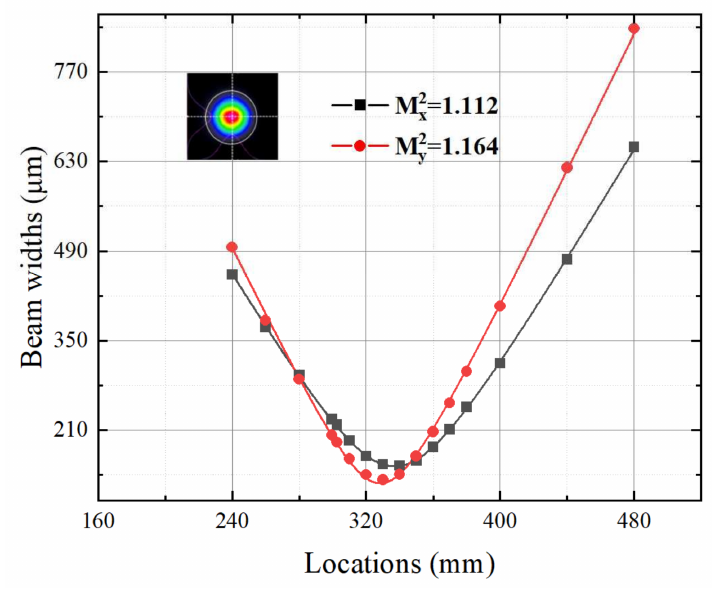
Figure 8. Quality factor M 2 of the 532 nm